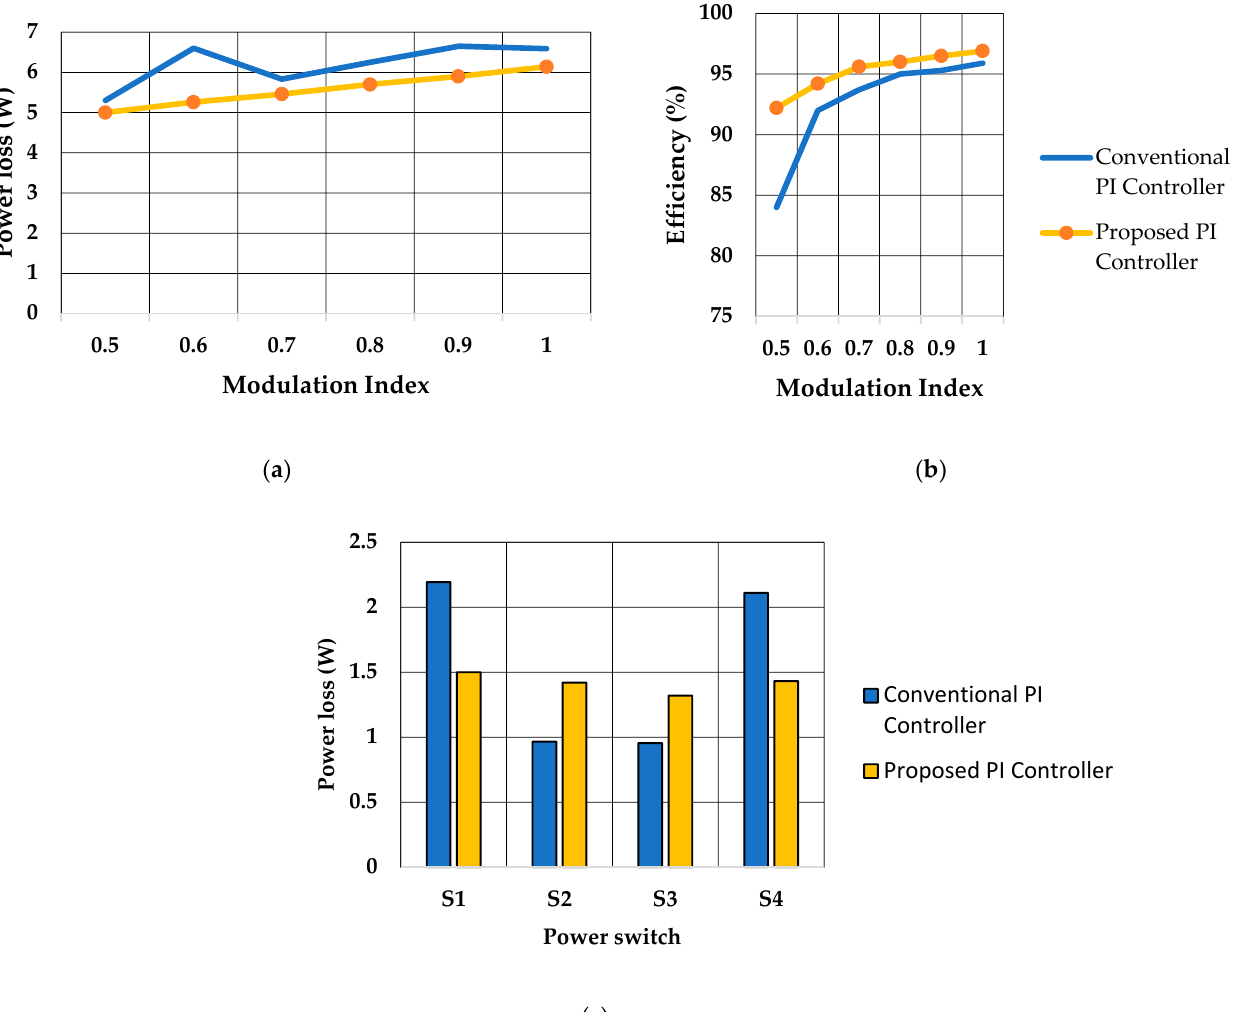
Figure 10. Simulation results of power loss and efficiency with respect to modulation index. ( a ) Total power loss ( b ) Efficiency ( c ) Power distribution among the power switches at 0.9 modulation index.